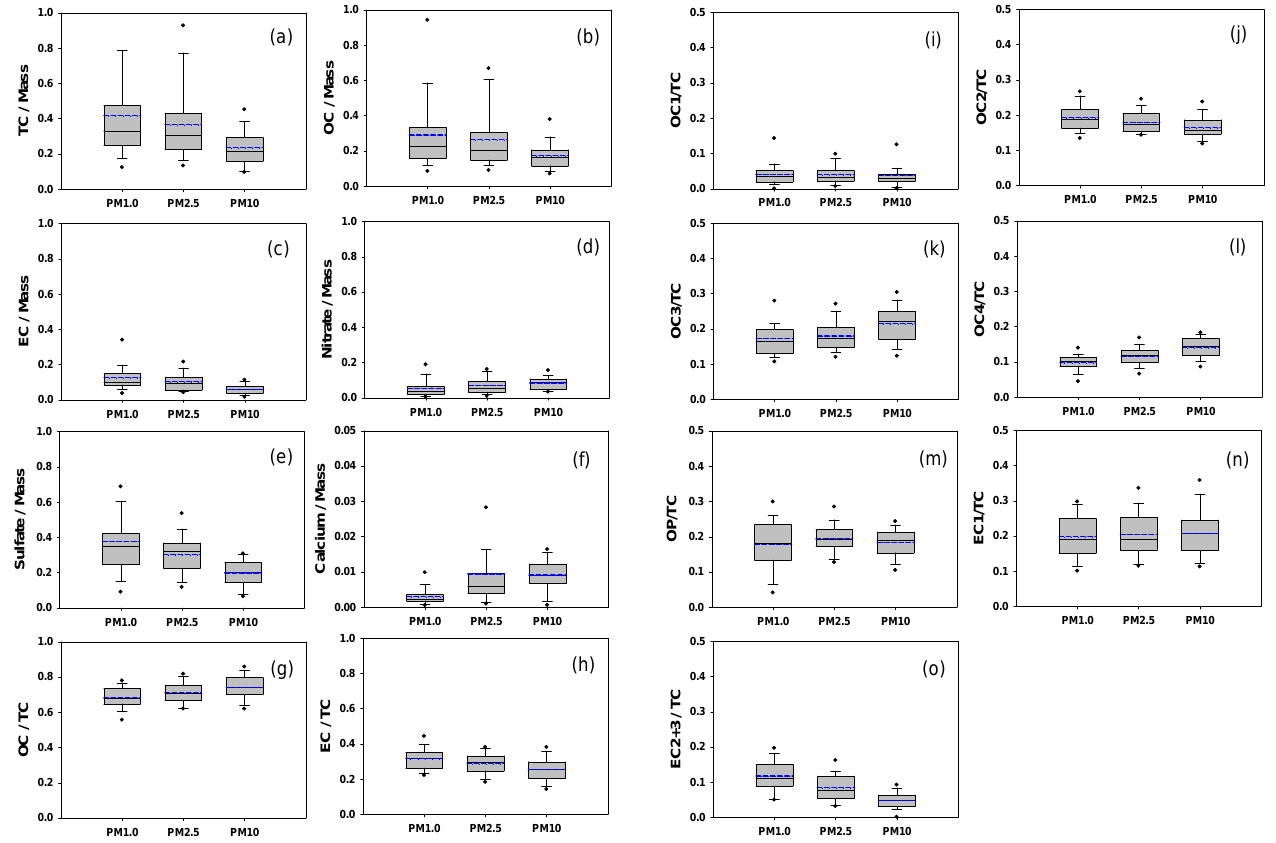
Figure 3 Fig. 3. Ratios of each chemical component to mass or total carbon (TC=OC+EC) in PM 1 . 0 , PM 2 . 5 , and PM 10 : (a) total carbon-to-mass, (b) OC-to-mass, (c) EC-to-mass, (d) nitrate-to-mass, (e) sulfate-to-mass, (f) calcium-to-mass, (g) OC-to-TC, (h) EC-to-TC, (i) OC1-to-TC, (j) OC2-to-TC, (k) OC3-to-TC, (l) OC4-to-TC, (m) OP-to-TC, (n) EC1-to-TC, (o) EC2+3-to-TC. Total Carbon (TC) is the sum of OC and EC, which are the sum of 5 sub-components (OC1, OC2, OC3, OC4, and OP) for OC and 3 components (EC1, EC2, and EC3) for EC (Han et al., 2007, 2010). OP stands for pyrolyzed organic carbon. Solid and blue dotted lines within the box denote the median and the mean value, respectively, and the box represents the 25th and 75th percentiles. Whiskers above and below the box indicate the 90th and 10th percentiles, and solid circles are outliers corresponding to 5th and 95th percentiles of the data. were 13.7 µg m − 3 for PM 1 . 0 , 17.2 µg m − 3 for PM 2 . 5 ,